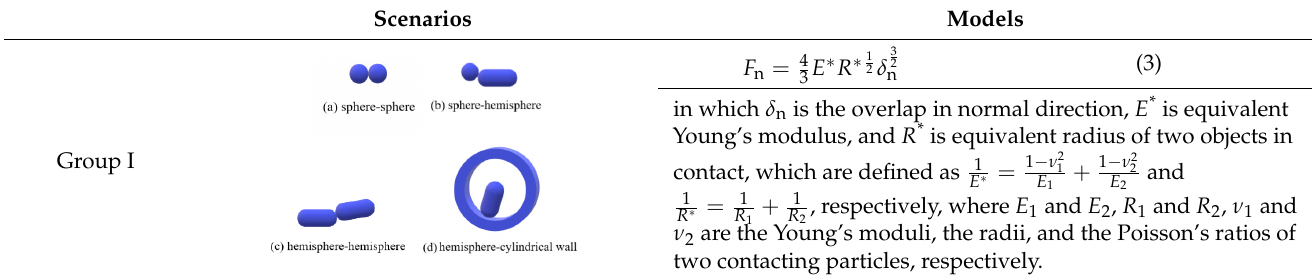
Table 1. Contact force models used in the DEM simulations.